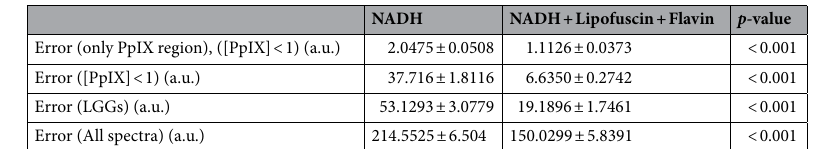
Table 1. Mean fit error between measured and unmixed spectra (a.u.) from various groups, and over either the whole spectrum (420 nm to 730 nm) or just the PpIX region (600 nm to 730 nm).